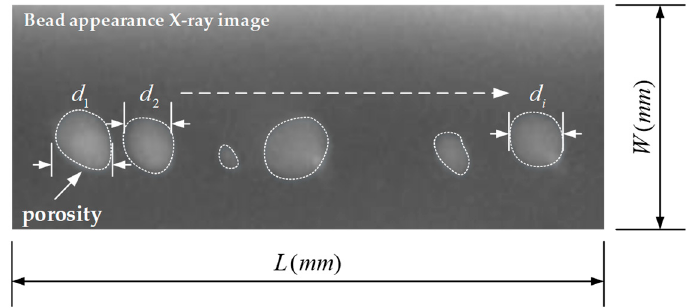
Figure 4. Total porosity area measurement.